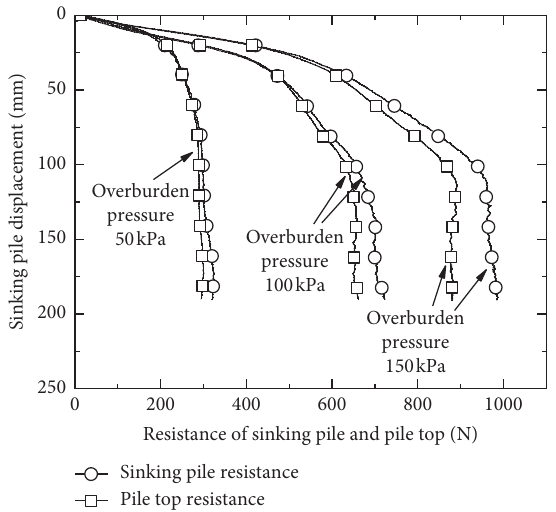
Figure 10: Relation curves for pile sinking (pile tip) resistance-pile sinking displacement.